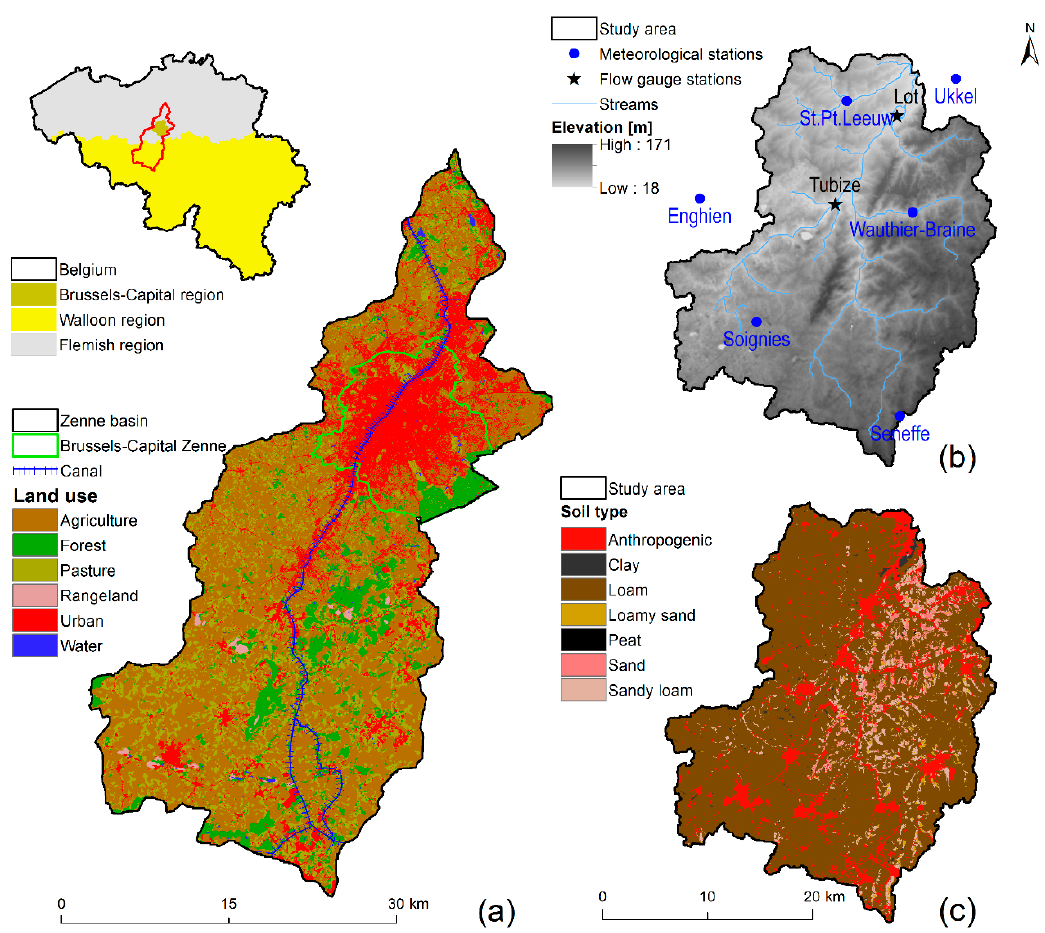
Figure 1. Location of the Zenne basin in Belgium (top left corner), Zenne basin land use with Canal ( a ), Digital Elevation Model (DEM) with hydro-meteorological stations ( b ), and soil type ( c ) for the area upstream from Brussels.